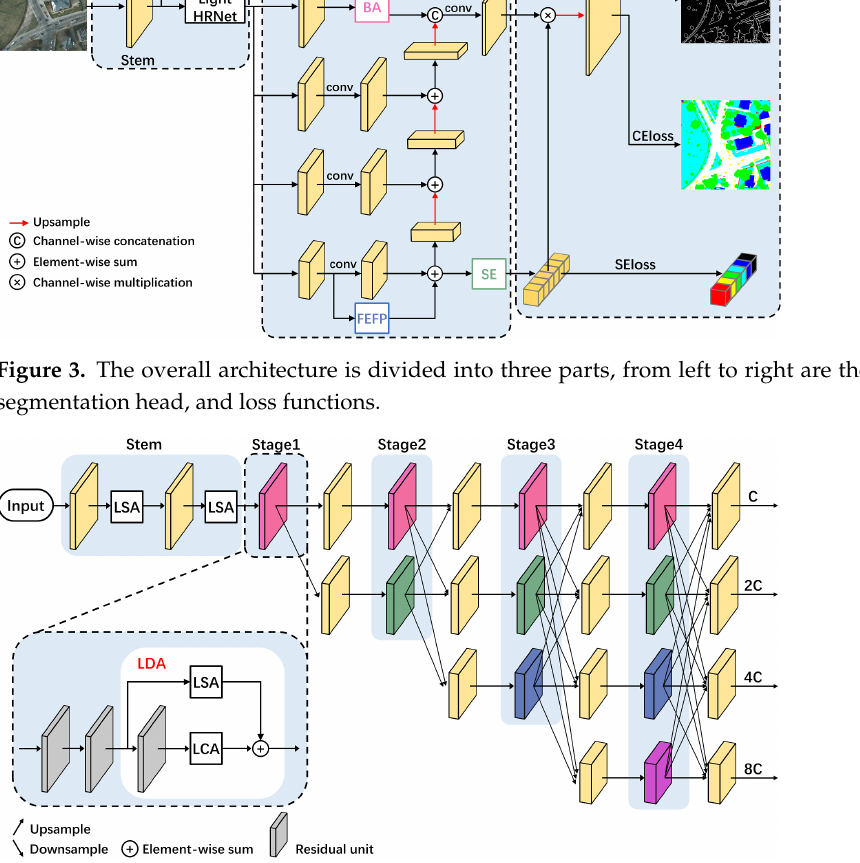
Figure 4. Light-weight dual attention (LDA) module is applied to the four stages (Stage1, Stage2, Stage3, and